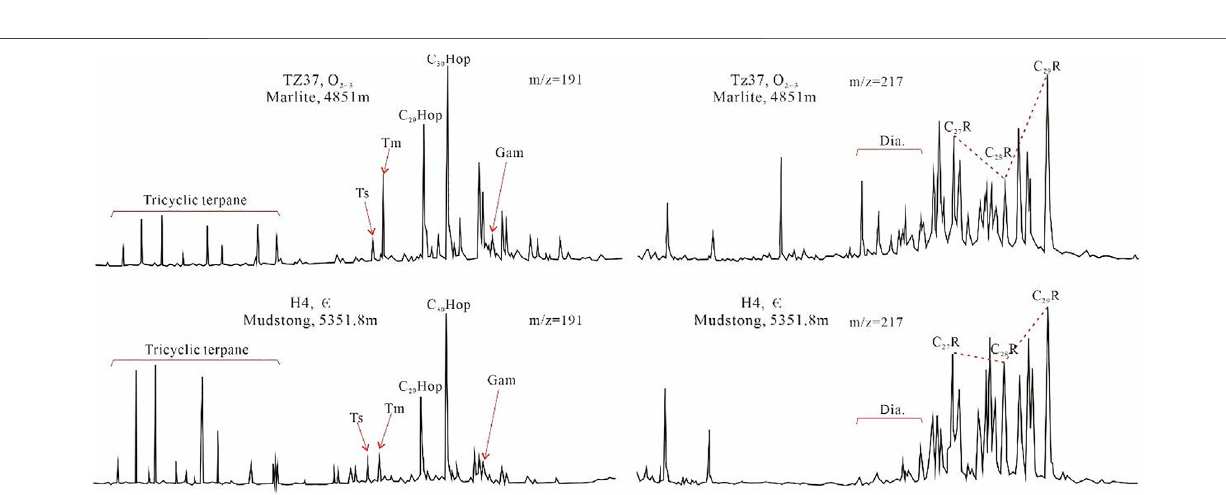
FIGURE 3 | Chromatograms of steranes and terpanes of Cambrian-Lower Ordovician and Middle-Upper Ordovician source rocks in well Tazhong 37 and well He 4.